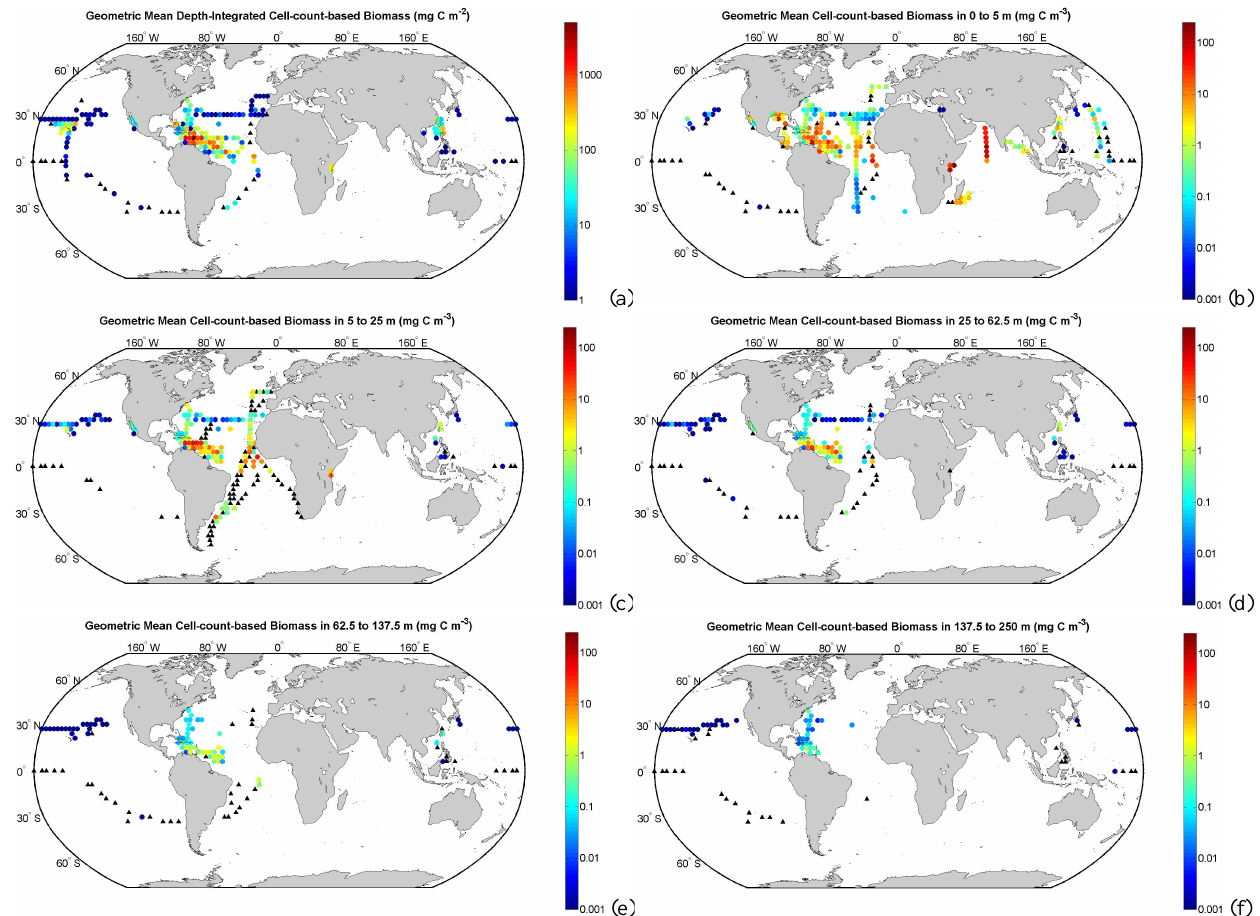
Figure 8. (a) Geometric mean depth-integrated cell-count-based diazotrophic carbon biomass binned on 3 ◦ × 3 ◦ grid. Also geometric mean cell-count-based diazotrophic carbon biomass on 3 ◦ × 3 ◦ grid for 5 vertical layers of (b) 0–5m, (c) 5–25 m, (d) 25–62.5m, (e) 62.5–137.5m and (f) 137.5–250m. The color bar is in logarithmic scale. Zero values are marked with black